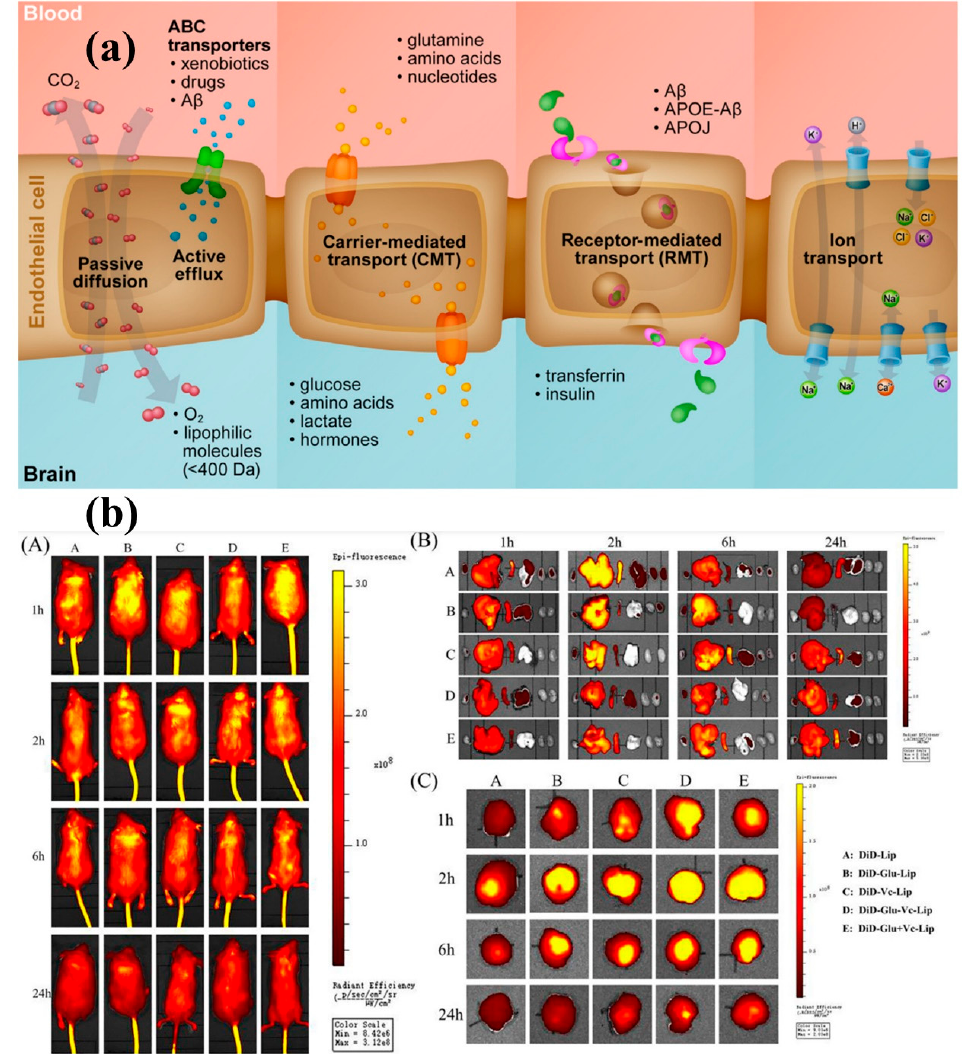
Figure 9. ( a ) Transport mechanism of O 2 , CO 2 and lipophilic molecules across BBB (adapted with permission from [72] Elsevier, 2020) ( b ) In vivo and ex vivo images of drug loaded liposome adminis- trated mice after 1, 2, 6 and 24 h (adapted with permission from [5], Elsevier,